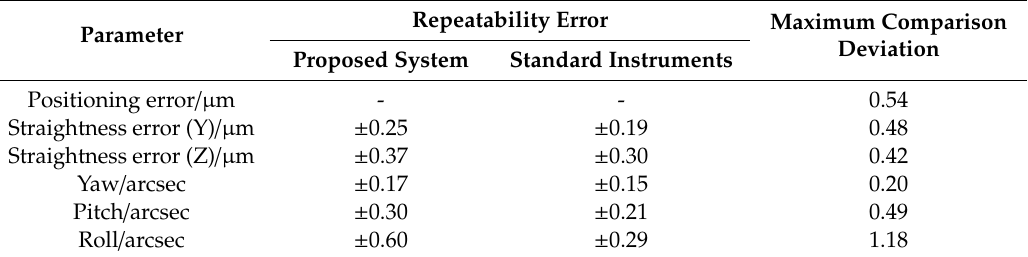
Figure 6. Results of repeatability tests and comparison experiments. Table 3. Performance of the 6DOF system